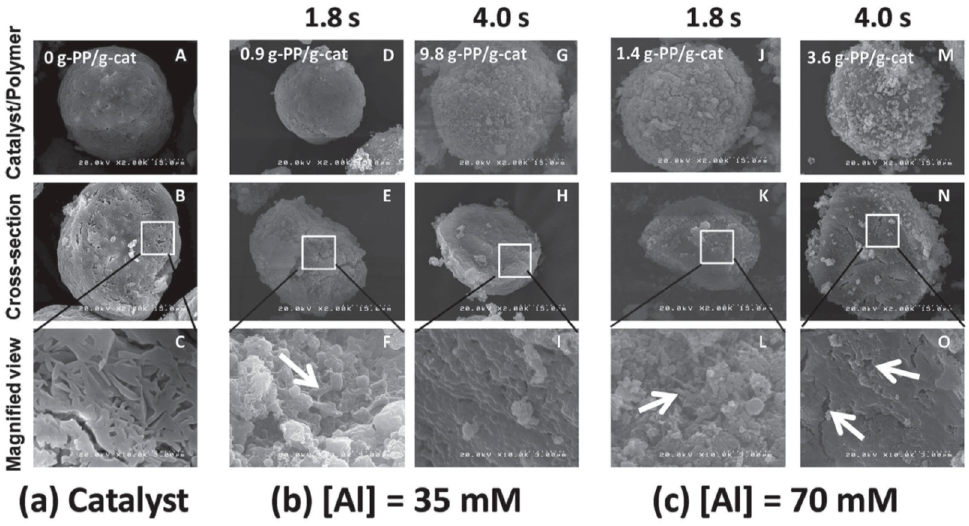
Figure 9. Scanning electron microscopy (SEM) images of surface and bulk morphology of: ( a ) A catalyst particle; (b) Polymer / catalyst particles obtained from LSF propylene polymerization at [Al] = 35 × 10 − 3 M; (c) Polymer / catalyst particles obtained from LSF propylene polymerization at [Al] = 70 × 10 − 3 M [39].